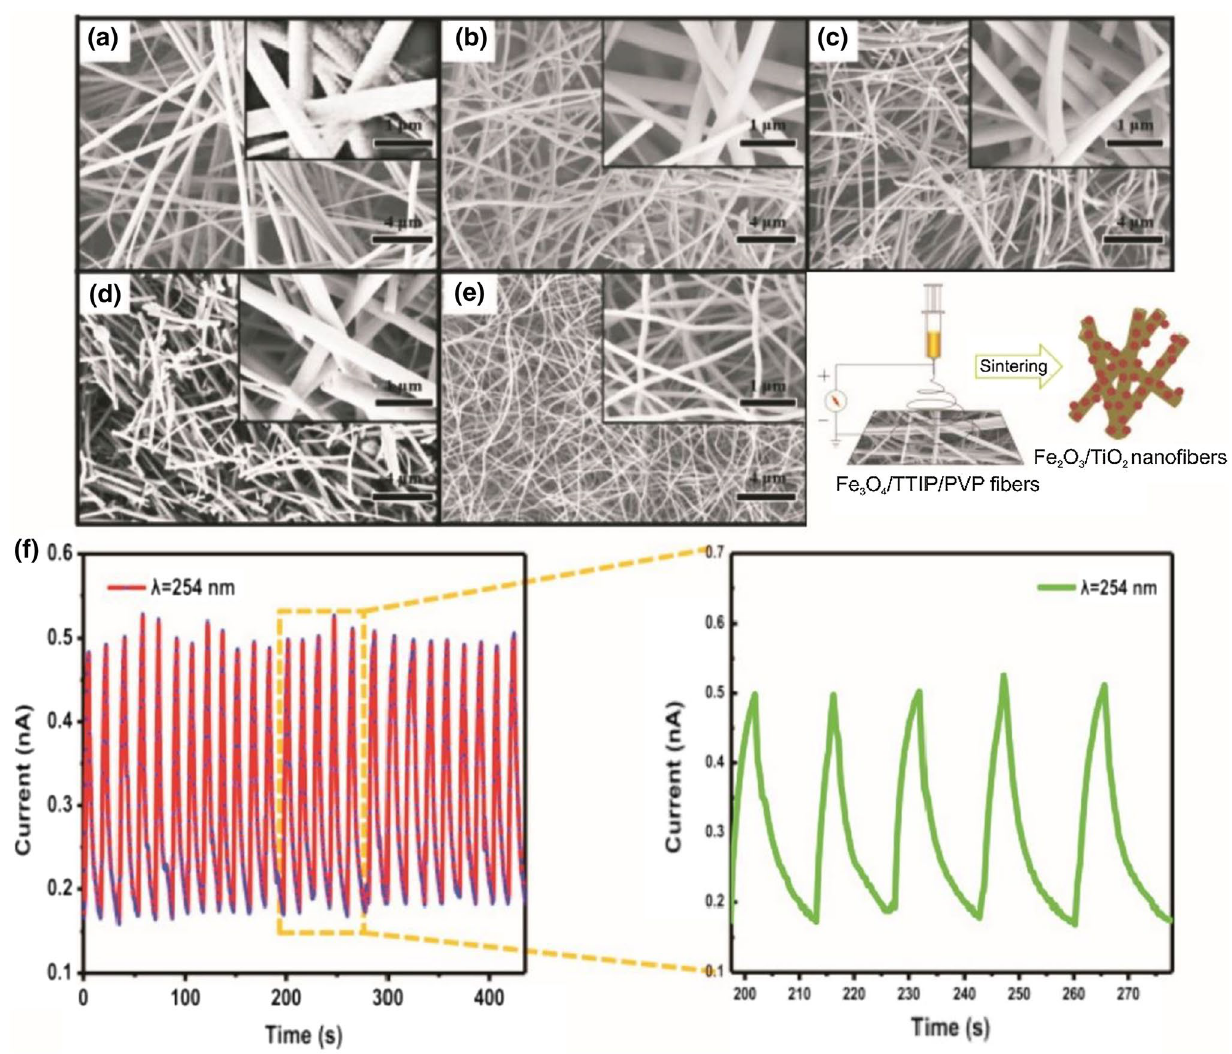
Fig. 8 SEM images of ( a ) original Fe 500, 550 and 600 °C, respectively, and ( e ) pure TiO method. f Response curves of the nanofibers synthesized at 550 °C with the UV light irradiation at 254 nm. Reproduced from [56] with per- mission of